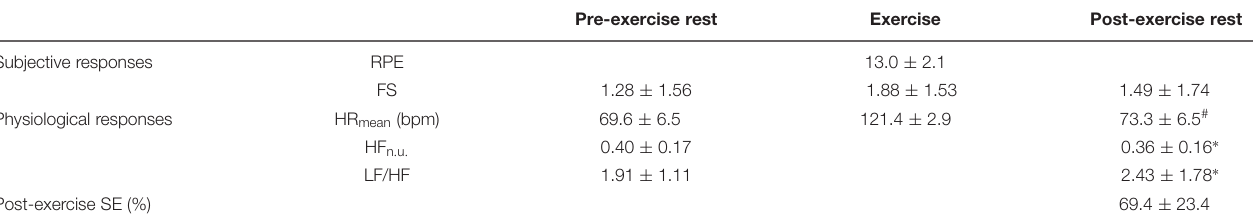
TABLE 2 | Subjective and physiological responses to exercise and post-exercise SE.